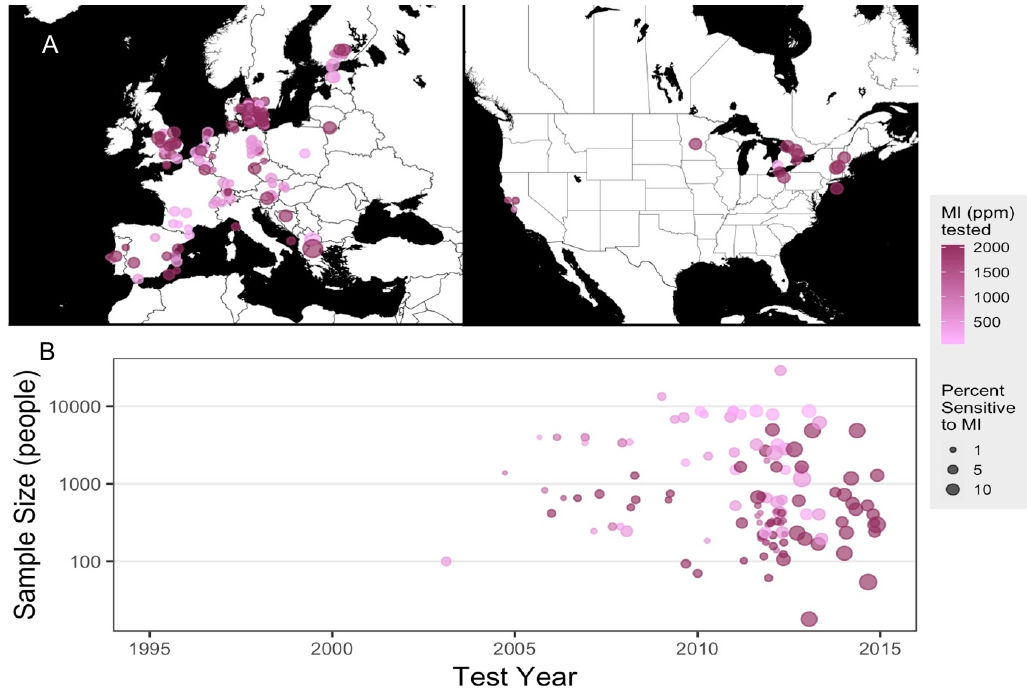
Figure 1. Population level sensitization to methylisothiazolinone (MI) in Europe and North America. ( A ) Location of epidemiological studies conducted in Europe (left) and North America (right); all points plotted at the approximate latitude and longitude of the original study with random noise added for easier visualization. ( B ) Sample size reported by epidemiological studies in Europe and North America using MI patch tests. Point placement corresponds with the year each study ended. Sample size may include multi-year studies if yearly data were not available. Color gradient indicates the highest concentration of MI in parts per million (ppm) tested in each study and the size of the point represents the proportion of the population that tested sensitive to MI. Studies in which MI ppm were not reported are excluded from the plot. The size of each point represents the percent of participants that were found to be sensitized to MI ( n = 151 studies).